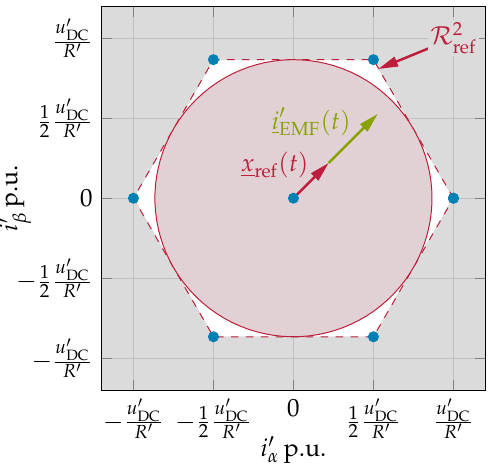
( t ) in the ( α , β ) -plane, corresponding R 2 EMF